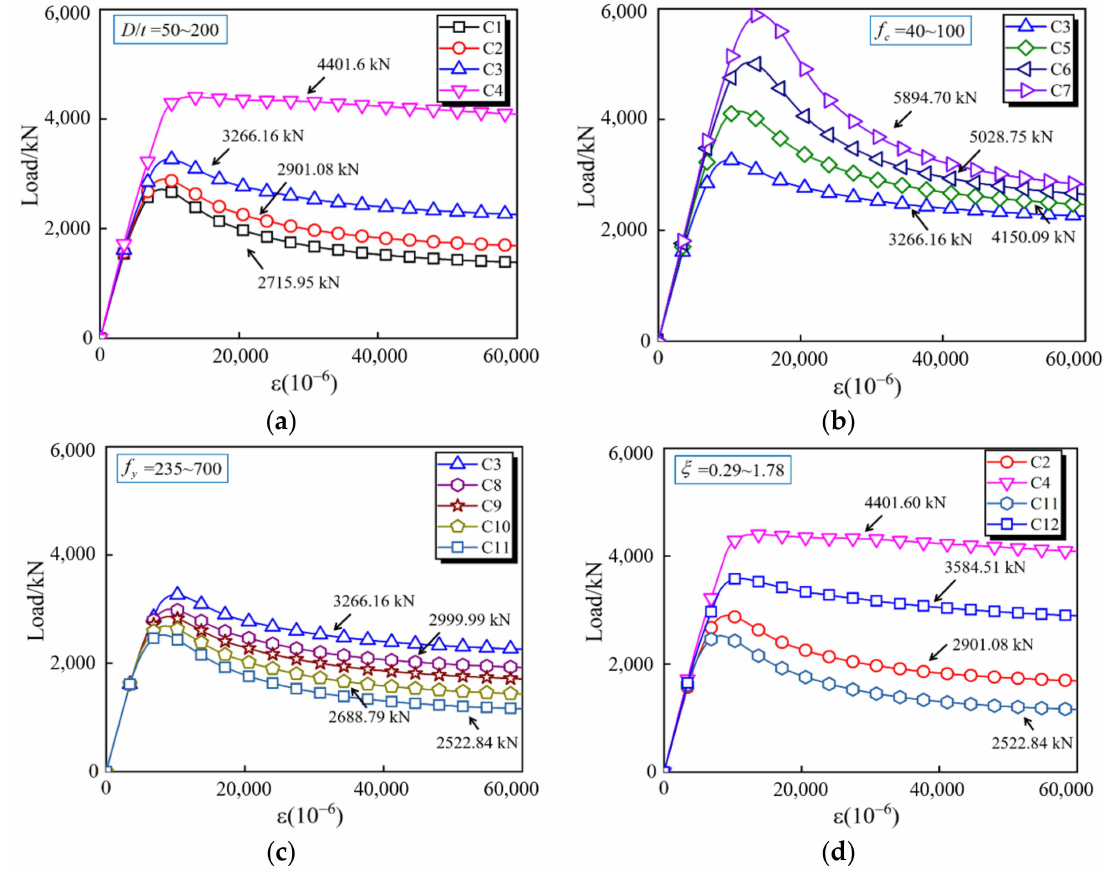
Figure 14. N- ε curves of FE models. ( a ) Effects of D / t ratio. ( b ) Effects of compressive strength of concrete. ( c ) Effects of steel yield strength. ( d ) Effects of confinement effect